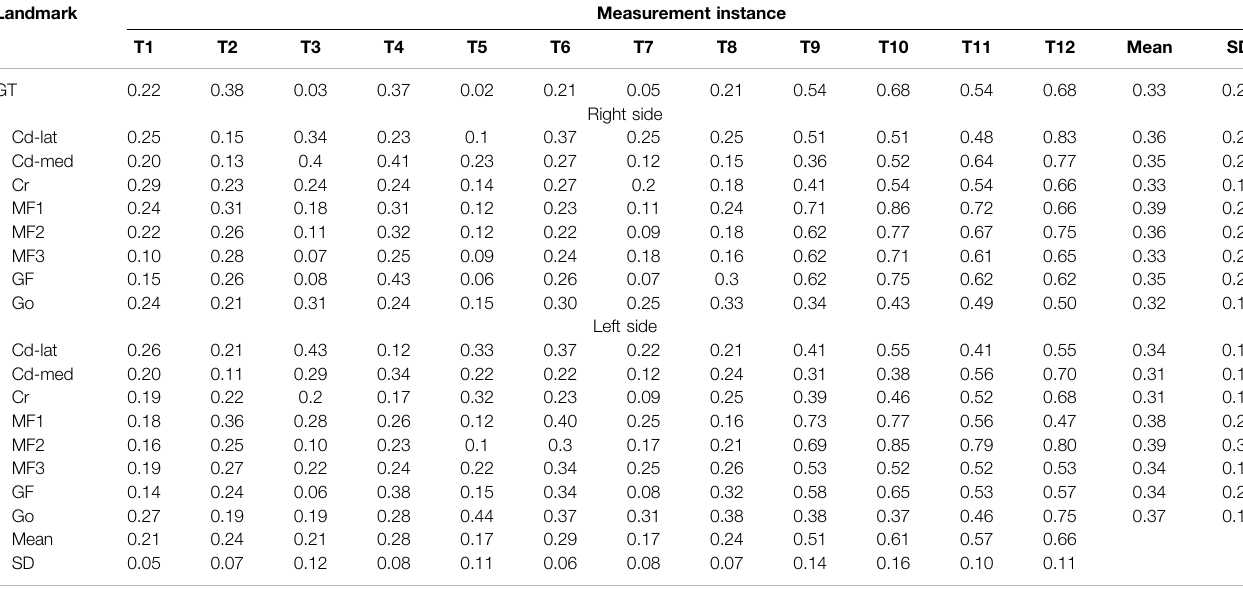
TABLE 2 | Root mean square errors (RMSE) of the positions between the new method and the gold standard for the 17 anatomical landmarks (validation points) across all subjects at 12 instances over the 48-week monitoring period. ( n = 8; unit: mm). Landmark Measurement instance